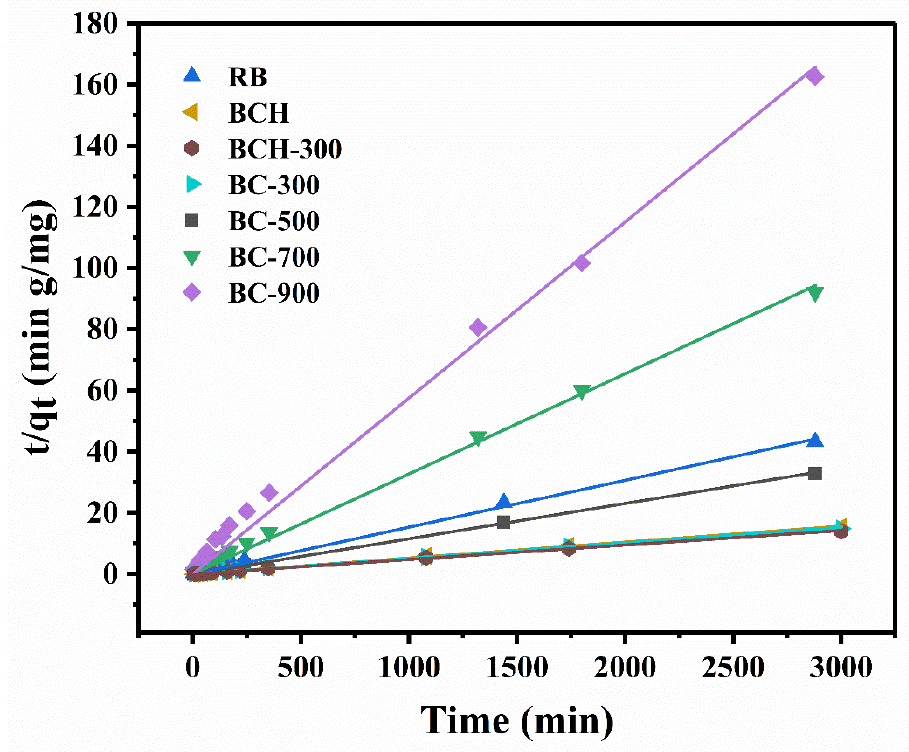
Figure 3. The pseudo-second kinetics model on sorption of Cd 2+ on various BC and BCH samples.